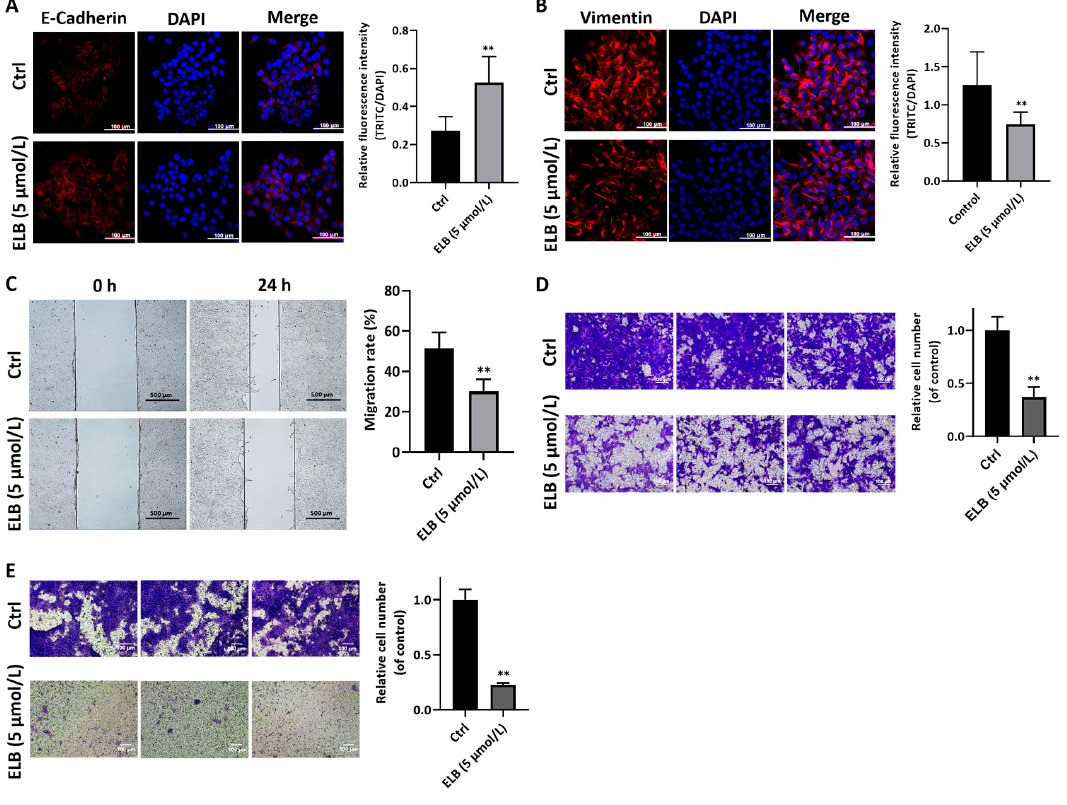
Figure 2. The role of eltrombopag in migratory and invasive of 4T1 cells. ( A ) Impact of eltrom- bopag to expression of E-cadherin protein in 4T1 cells, representative images and quantitative data of immunofluorescence experiments are shown (Scale bar: 100 µ m). ( B ) Impact of eltrombopag to expression of vimentin protein in 4T1 cells, representative images and quantitative data of im- munofluorescence experiments are shown (Scale bar: 100 µ m). ( C ) Scratch wound assay was used to determine the migration effect of eltrombopag on 4T1 cells, representative images and quantitative data are shown (Scale bar: 500 µ m). ( D ) Transwell migration experiment was used to determine